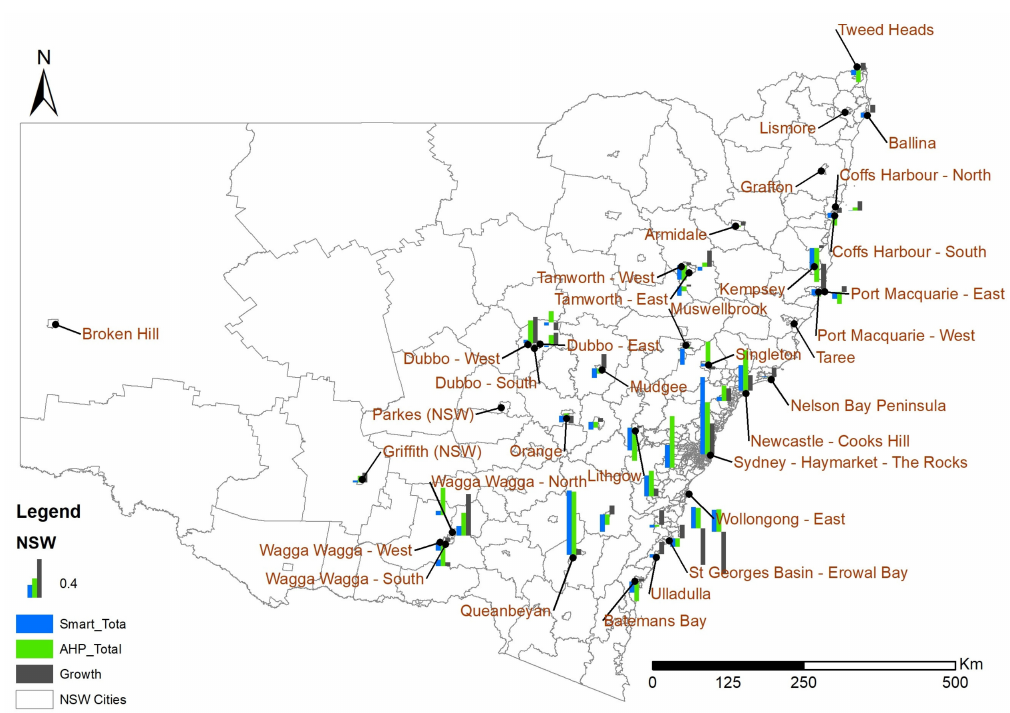
Figure 10. Smart Score of 44 cities of NSW along with Preference Score and 10-year population growth. In Victoria, the highest growth rate is observed in Melbourne that got the highest smart score (refer Figure 11). The performance of Melbourne is outlier Except for the Mildura, a border city with significant reduction in population, no city observed any significant growth or reduction in population. Newborough is the least smart and least preferred city in Victoria.